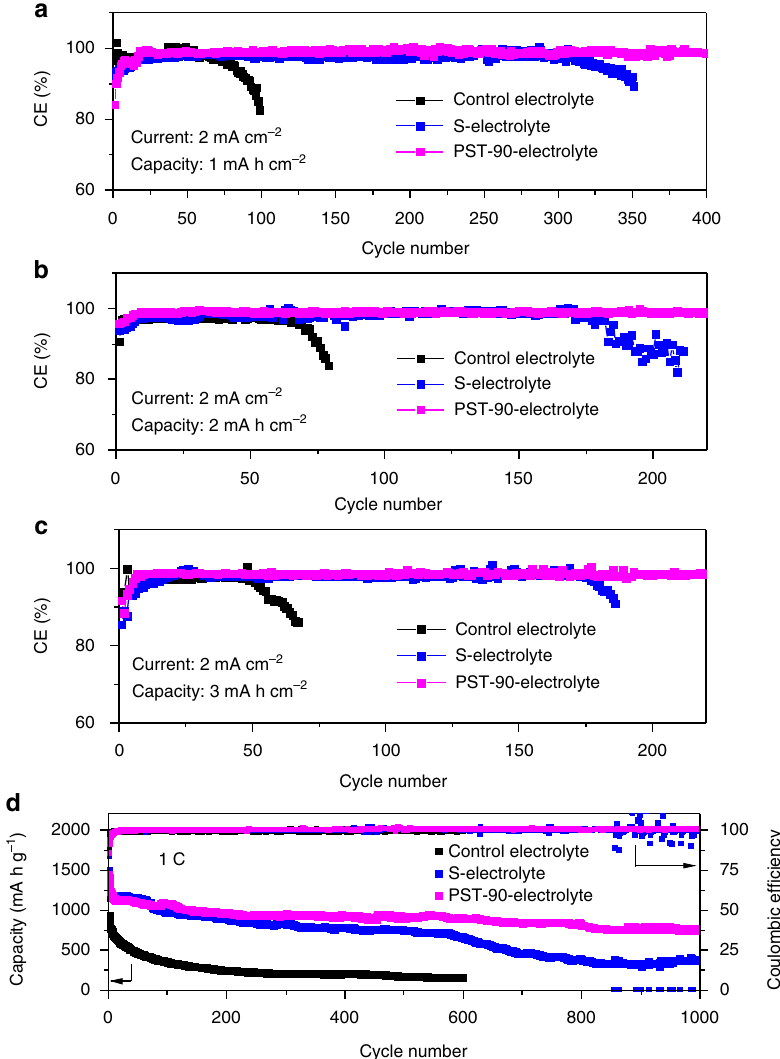
Fig. 5 Characterization of electrochemical performance. Cycling performances of the cells using PST-90-Electrolyte (magenta symbols) at a current density of 2 mA cm − 2 with a deposition capacity of 1 mA h cm − 2 ( a ); at a current density of 2 mA cm − 2 with a deposition capacity of 2 mA h cm − 2 ( b ); at a current density of 2 mA cm − 2 with a deposition capacity of 3 mA h cm − 2 ( c ). The black and blue symbols represent data of the samples using the control electrolyte and the S-Electrolyte, respectively. d The electrochemical performance of the Li - S batteries using electrolytes containing different additives at a rate of 1C. The Ketjen Black (KB) containing 70 wt% S was used as the cathode material. The areal sulfur loading is 1.5 mg cm −